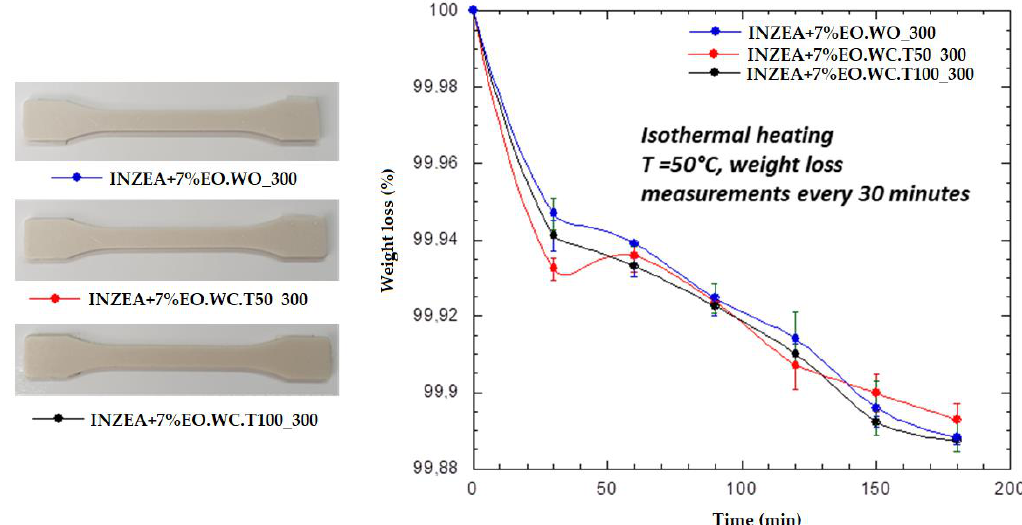
Figure 9. Visual images of samples and TGA results obtained for INZEA-based bio-nanocomposites including MMT hybrid samples functionalized with 300 wt% LEO.